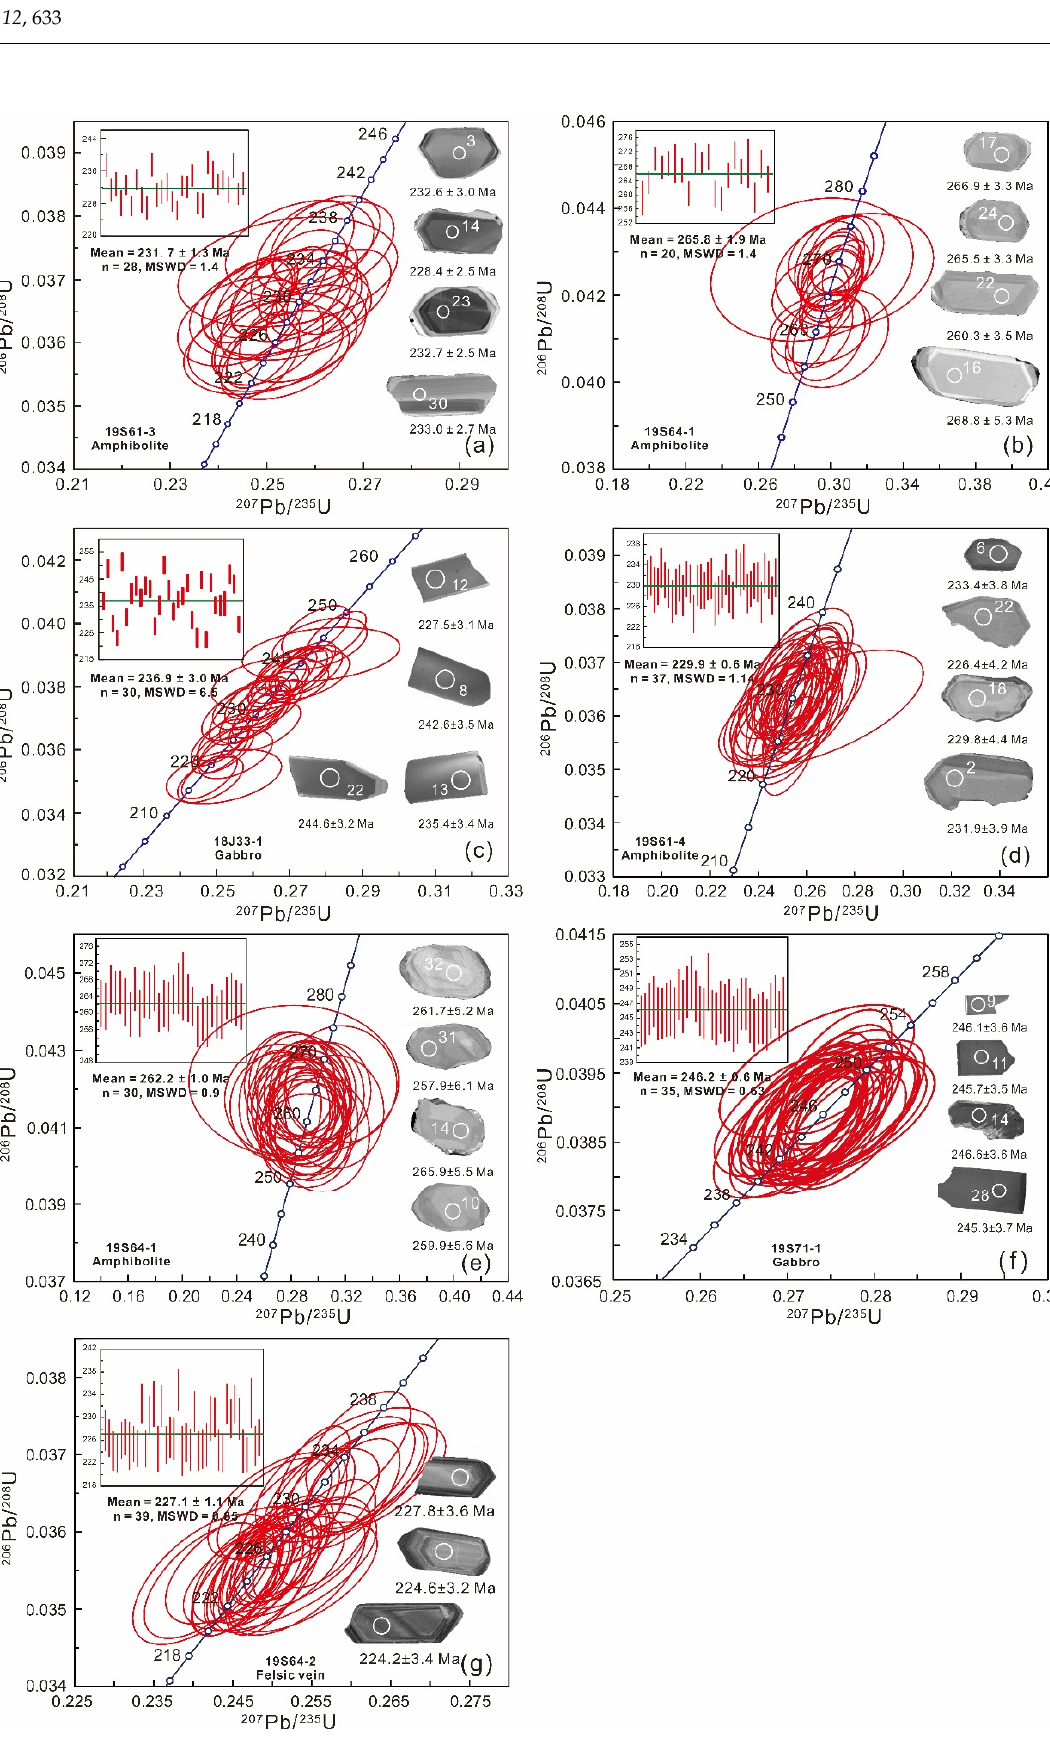
Figure 4. ( a – c ) Sensitive High-Resolution Ion Microprobe (SHRIMP) and ( d – g ) laser ablation inductively coupled plasma mass spectrometry (LA-ICP-MS) zircon U–Pb concordia diagrams with representative zircon images for the amphibolites from the JASB.